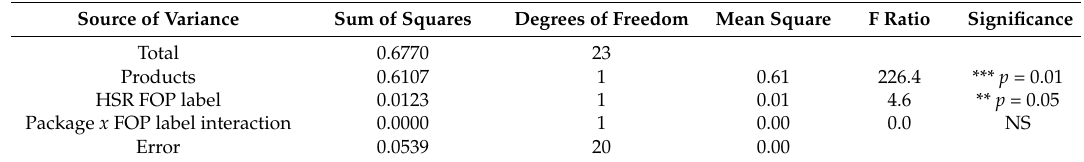
Table 2. Analysis of variance